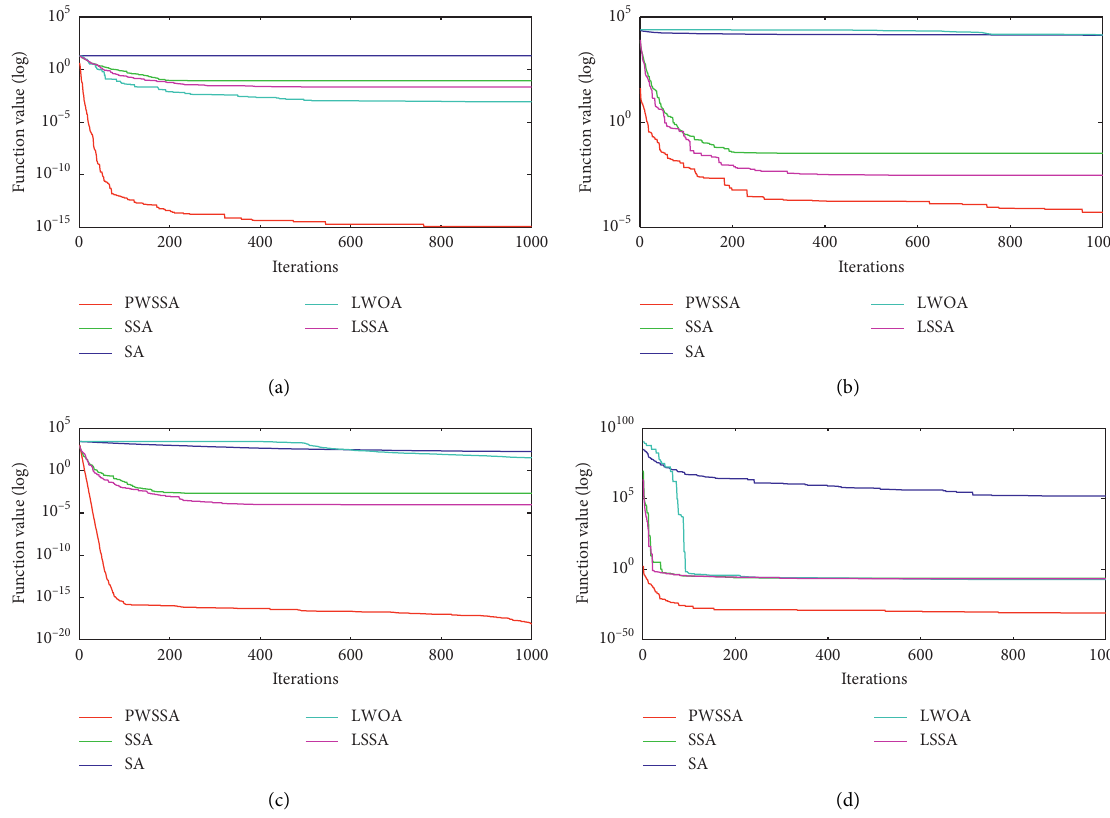
Figure 3: Convergence curves for functions ( D � 100). (a) f